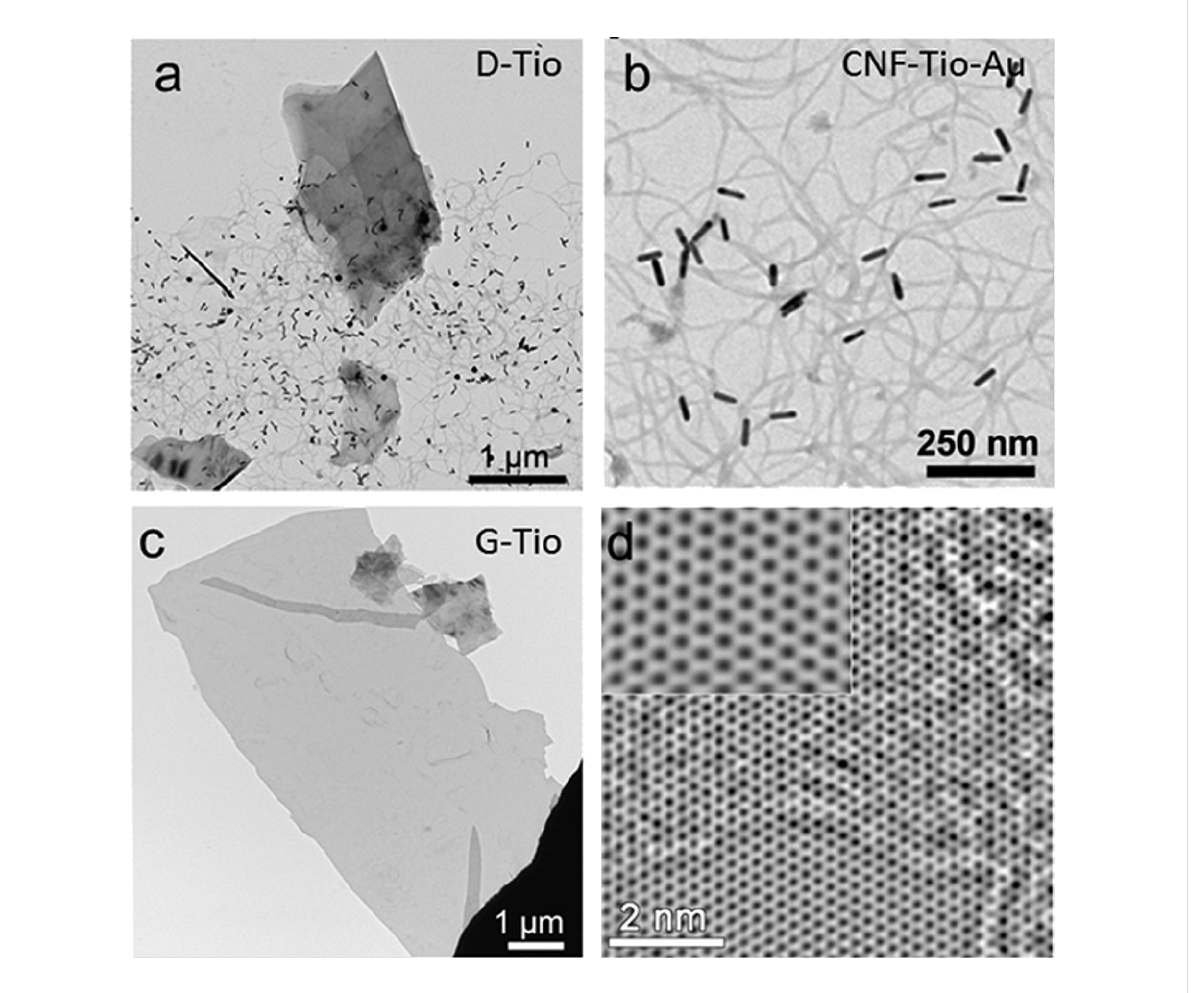
Figure 2: Carbon nanostructures produced with the addition of tiopronin. (a) TEM micrograph of a solution cast including graphene layers and carbon nanofibers. (b) Carbon nanofibers marked with Au Nanorods. (c) Representative TEM micrograph of a graphene sheet. (d) HR-TEM image of graphene. Reprinted with permission from [9], copyright 2012 The Royal Society of